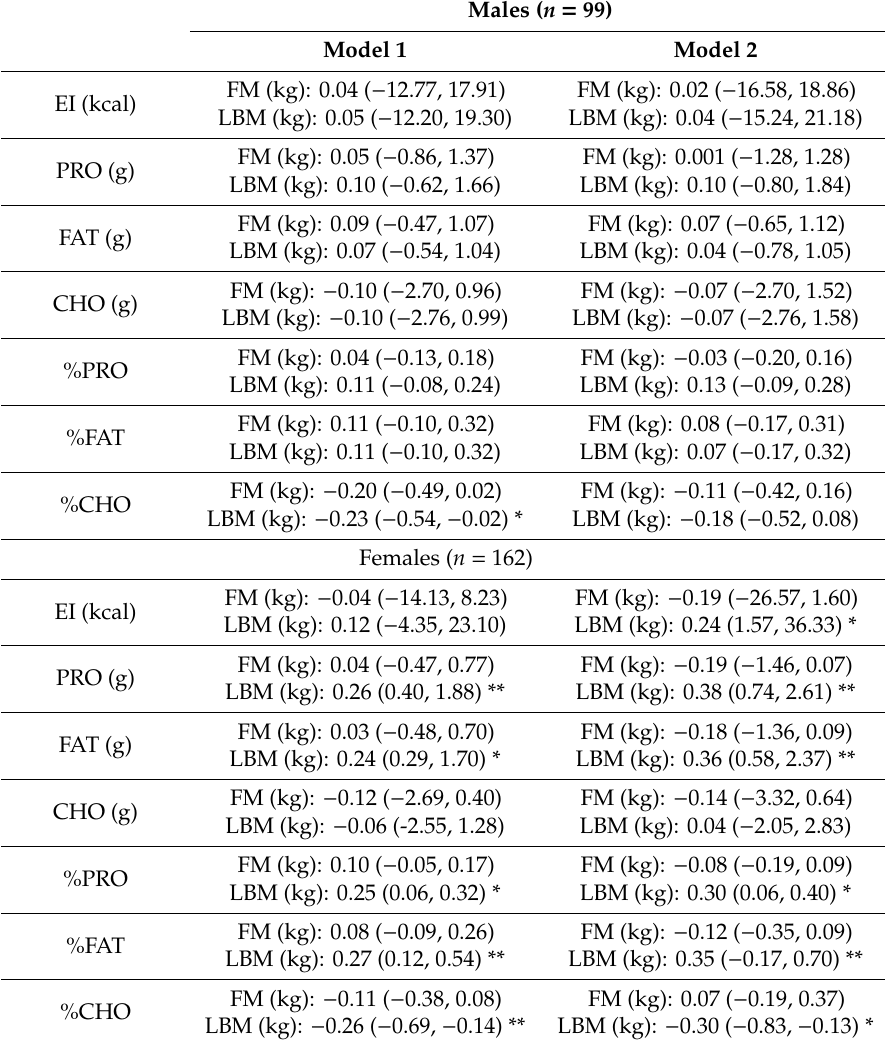
Table 3. Sex-specific multivariable-adjusted regressions analysis for body composition variables with daily macronutrient intakes of the study population.